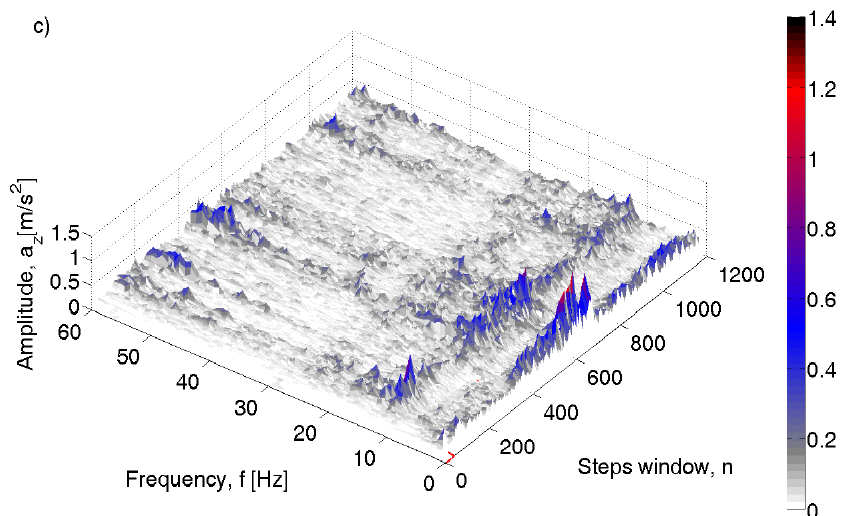
Figure 8. STFT spectrum of the car body acceleration signal in the vertical direction for the: ( a ) road surface A, ( b ) road surface B, ( c ) road surface C.